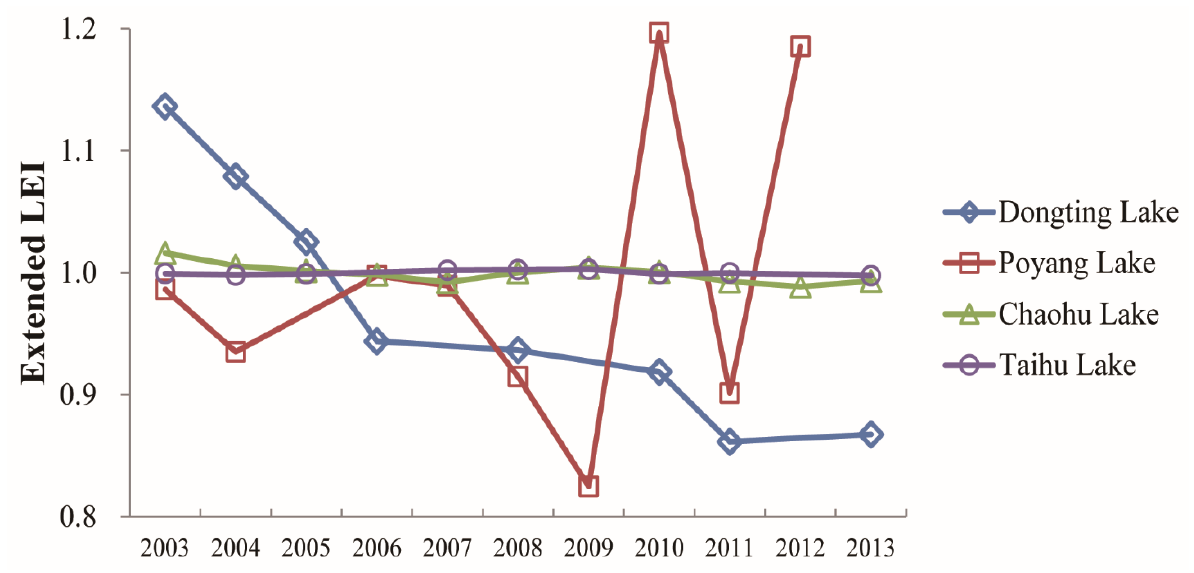
Figure 5. The extended LEI of the four lakes from 2002 to